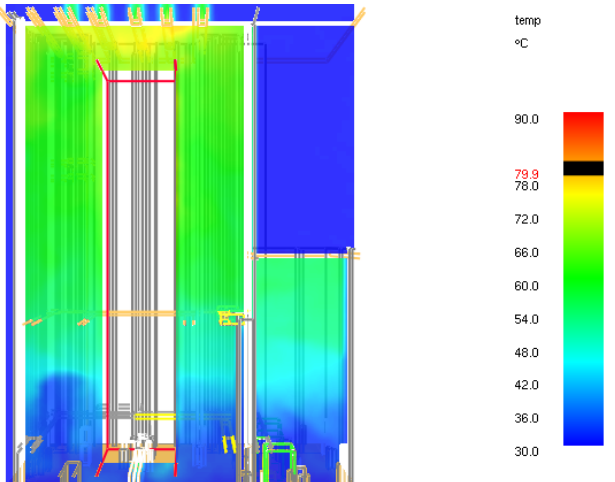
Figure 8. Ventilation air velocities in the boiler house during a fire under ventilation conditions.